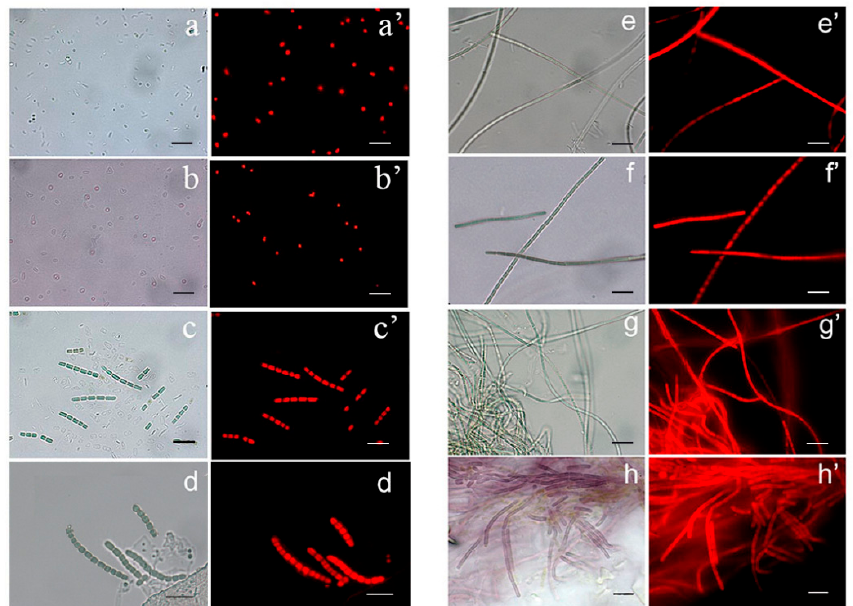
Figure 1. Light micrographs of the cyanobacterial strains and respective micrographs highlighting the red fluorescence of their photosynthetic pigments. ( a , a’ ) strain Cyanobium sp. ITAC108; ( b , b’ ) Synechococcus sp. ITAC107; ( c , c’ ) Pseudanabaena sp. ITAC106; ( d , d’ ) Pseudanabaena sp. ITAC102; ( e , e’ ) Leptolyngbya ectocarpi ITAC103; ( f , f’ ) undetermined Oscillatoriales ITAC105; ( g , g’ ) Halomicronema cf. metazoicum ITAC104; ( h , h’ ) Halomicronema metazoicum ITAC101. Scale bars = 10 μ m.